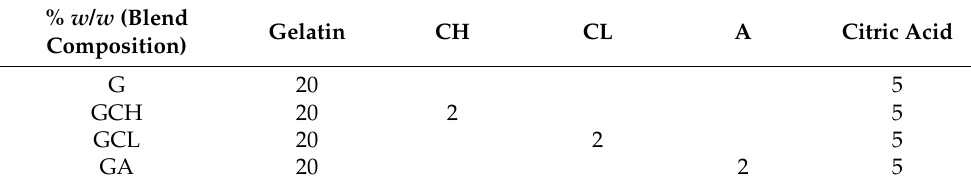
Table 1. Quali-quantitative composition of the polymeric blends. Abbreviations: CH (high molecular weight chitosan), CL (low molecular weight chitosan), A (alginic acid sodium salt), G (gelatin), GCL (gelatin-low molecular weight chitosan), GCH (gelatin-high molecular weight chitosan) and GA (gelatin- alginic acid sodium